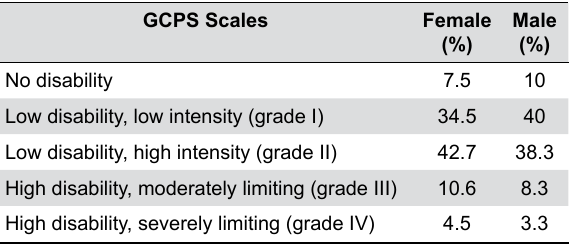
Table 3- Percentage of genders according to GCPS category